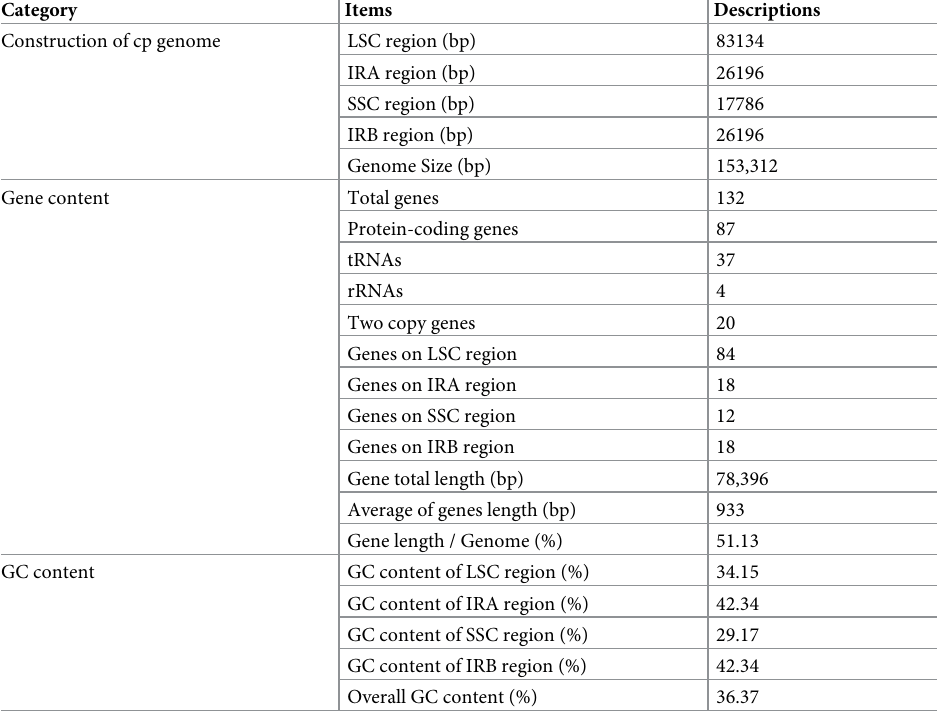
Table 1. The detail characteristics of the complete cp genome of Moricandia arvensis .